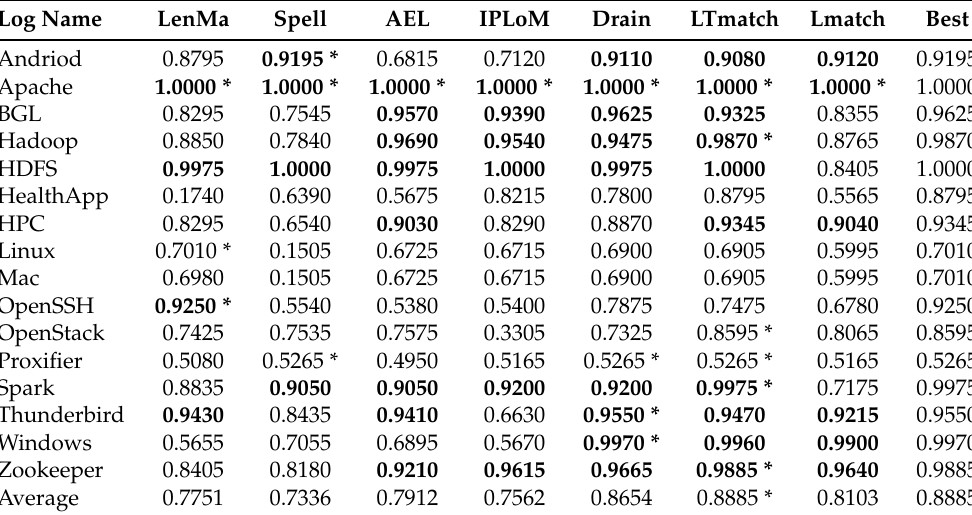
Table 2. The average accuracy of the results on different kinds of log.